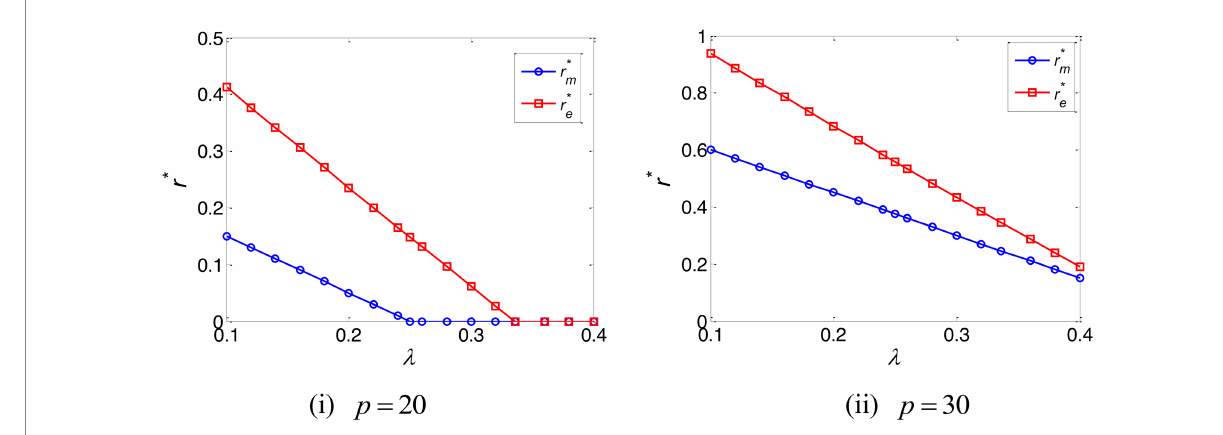
FIGURE 3 The optimal interest rate of the manufacturer and e-commerce